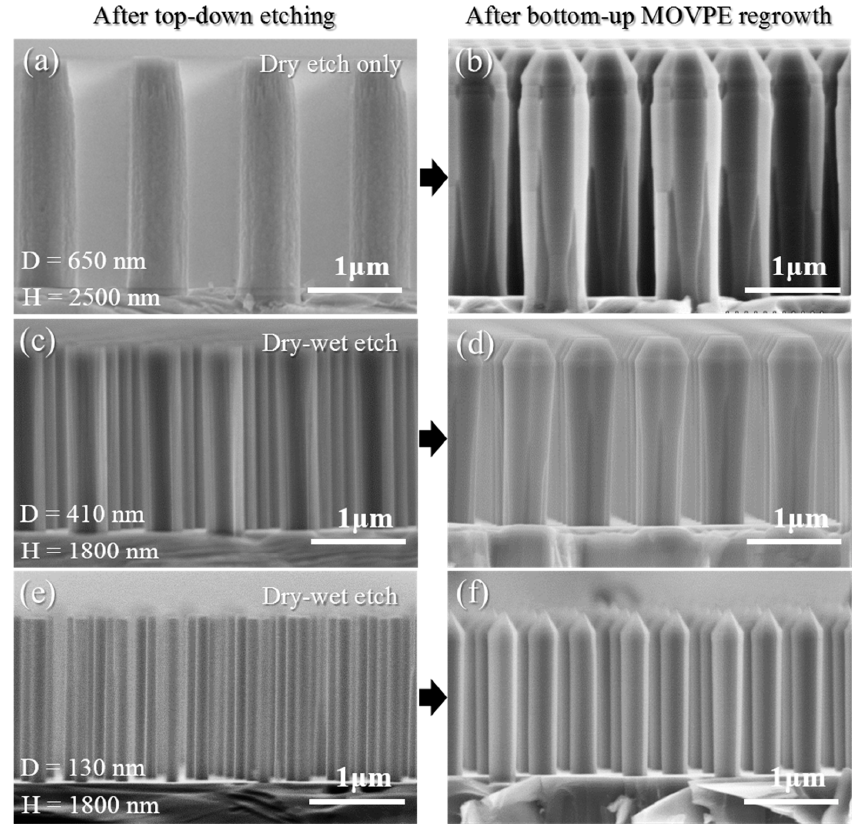
Figure 7. AlN etched nanorods achieved with ( a ) a 650-nm-diameter metal mask and a single step dry etch, ( b ) a 650-nm-diameter metal mask and a two-step dry-wet etch, and ( c ) a 250-nm-diameter metal mask and a two-step dry-wet etch; ( b , d , f ) 90 min AlN faceting regrowth from ( a , c , e